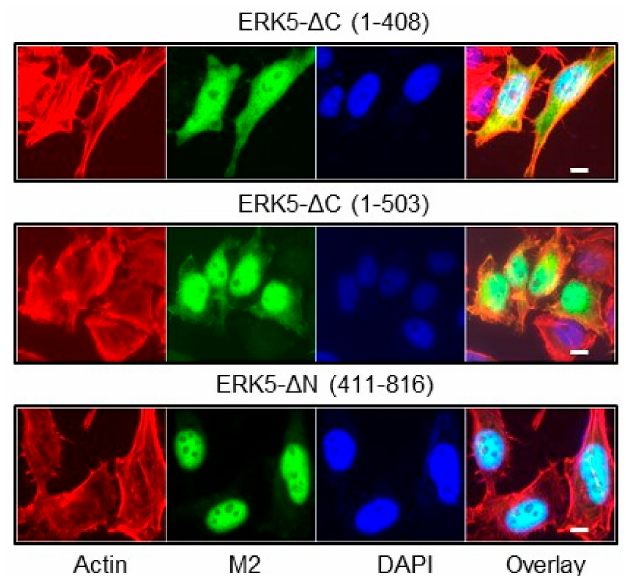
Figure 3. Subcellular localization of C- and N-terminal truncated ERK5 mutants. Recombinant Flp-In HeLa cell lines were grown on glass coverslips and incubated with tetracycline for 24 h before fixation. Subcellular localization of ectopically expressed ERK5- ∆ C and ERK5- ∆ N truncated mutants was visualized using an antibody to the Flag-tagged epitope (M2, green). Phallodin staining (red) was used to detect actin. Nuclei were detected with DAPI (blue). Scale bars: 10 µ